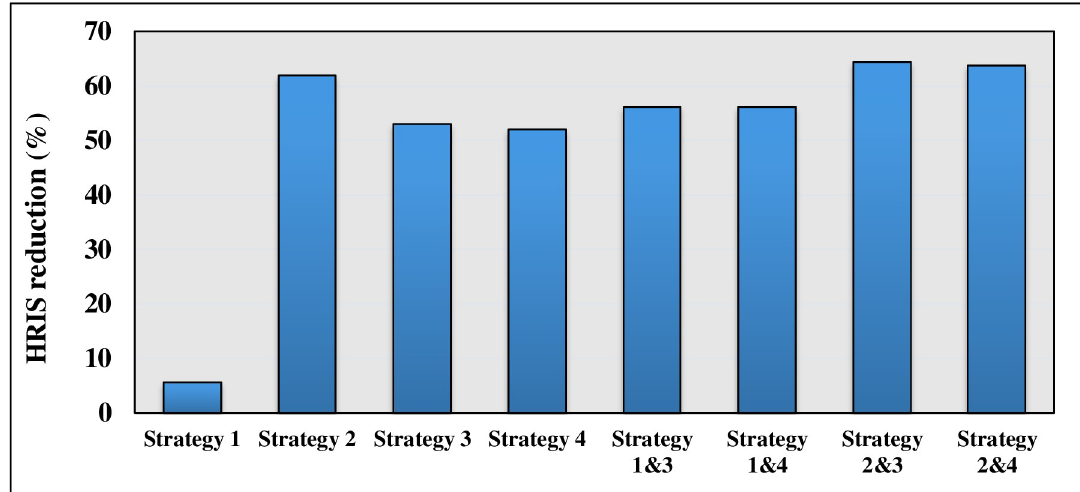
Fig 11. Comparison of the impact of different strategies on